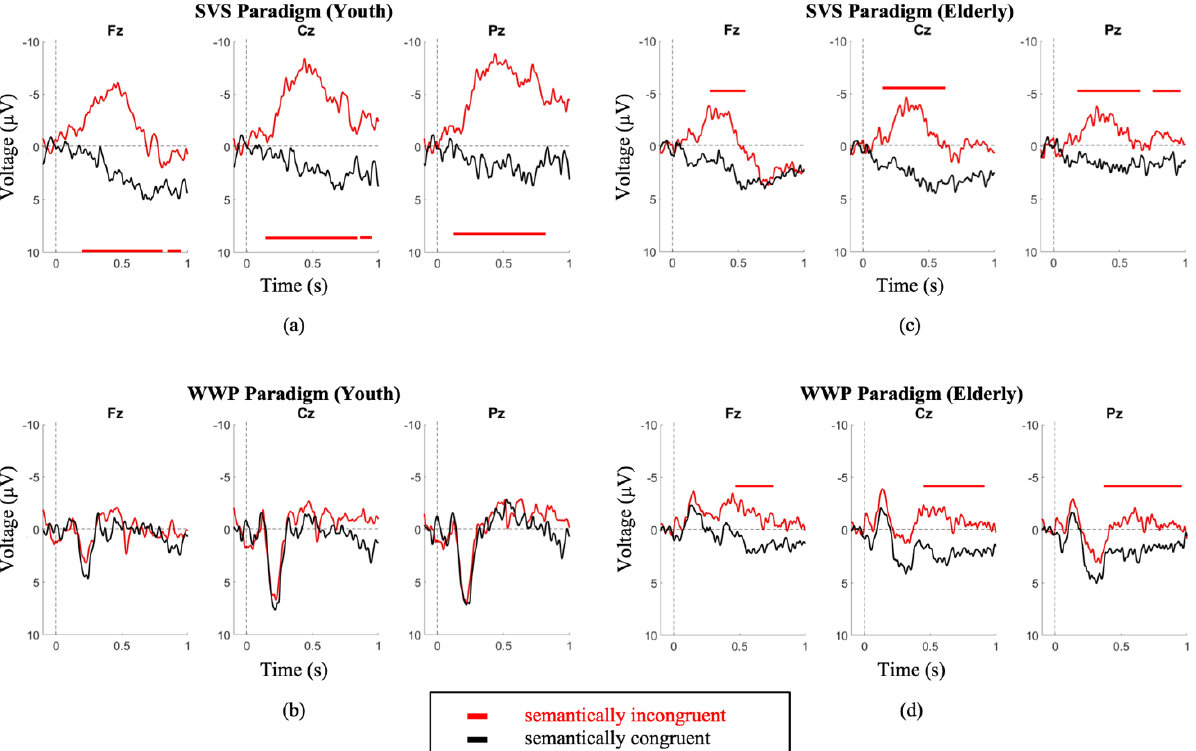
Figure 3. Youth ( a , b ) and Elderly ( c , d ) group grand average waveforms. the SVS paradigm elicited a larger N400 amplitude in the youth (Youth = − 8.7 ± 4 ( a ); Elderly = − 3.9 ± 2.8 ( c ); p = 3.3 × 10 − 2 ). The WWP paradigm elicited an N400 in the elderly ( d ) ( p < 0.05) but not in the youth ( b ). Intervals of significance indicate where the semantically incongruent waveform is significant in relation to the semantically congruent stimulus. Time periods where significant differences occurred are indicated by color-matched bars.